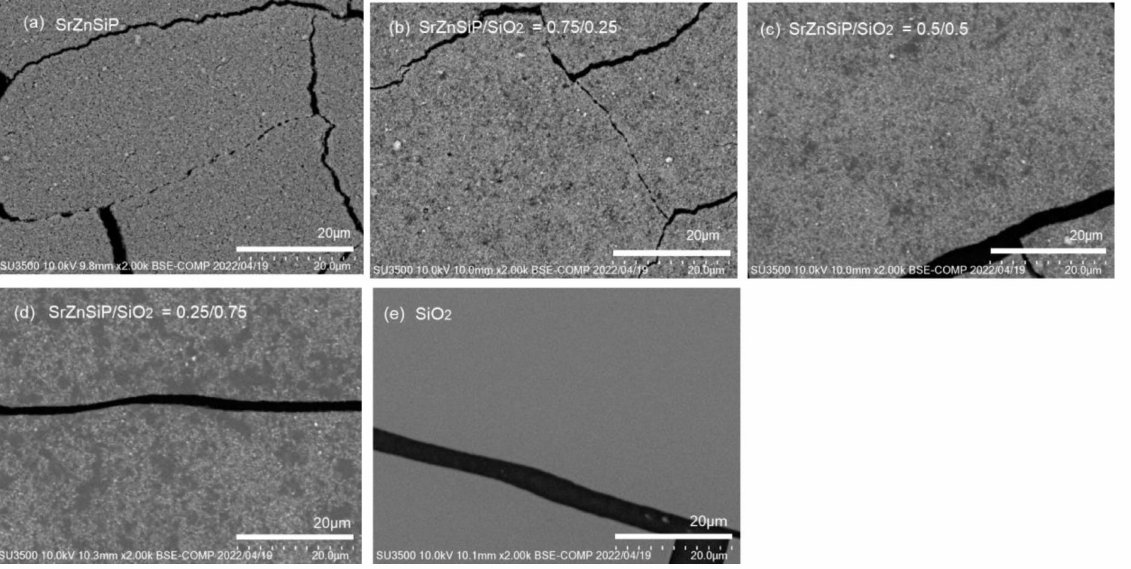
Figure 7. SEM observation of the UHMWPE disk coated by ( a ) SrZnSiP; ( b ) mixture of SrZnSiP and SiO 2 (0.75/0.25); ( c ) mixture of SrZnSiP and SiO 2 (0.5/0.5); ( d ) mixture of SrZnSiP and SiO 2 (0.25/0.75); and ( e ) SiO 2 , after CO 2 laser irradiation. Magnification 2 × K.